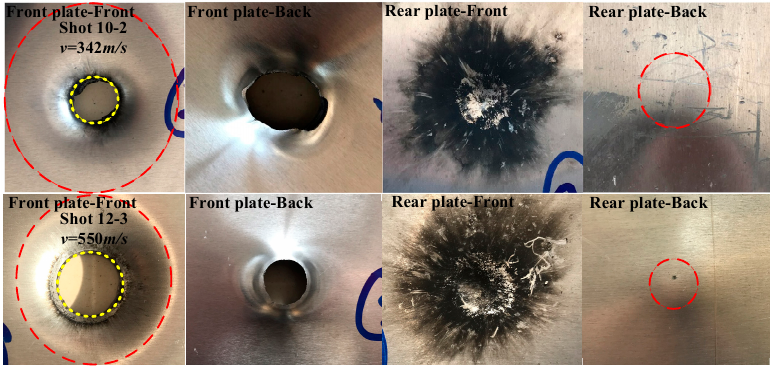
Figure 2. The damage patterns on the front and rear plate in shots 10-2 and 12-3. Table 1. Experimental results.